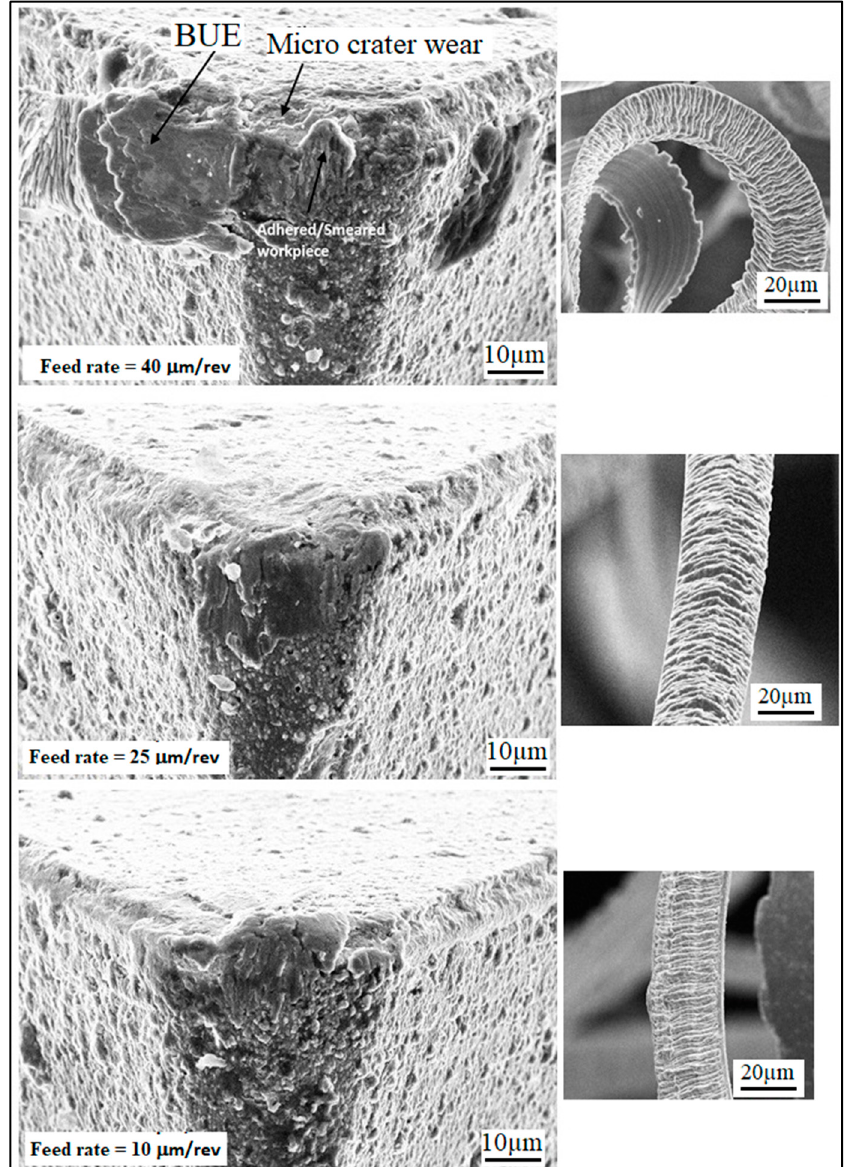
Figure 12. SEM images showing the effect of feed rate on the tool and chip morphology at V c = 250 m/min and a p = 15 µm.